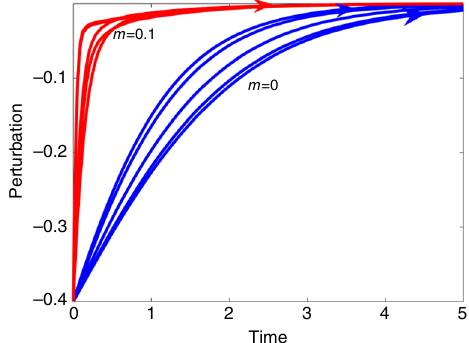
Fig. 1 Resilience of Mutualism. Trajectories of a perturbed n = 10 species Lotka – Volterra model Eq. (1) as it returns to equilibrium. Blue lines are systems with random positive and negative interaction coef fi cients having m ¼ E ð a 0 : 0 and σ ¼ 0 : 05. Red lines are simulations mutualistic ij Þ ¼ systems having random interactions with m ¼ E ð a 0 : 1, σ ¼ 0 : 05 and ij Þ ¼ all interactions positive. For all simulations, the population is depressed by 0.4 units initially, and the perturbation dies in time to zero. It is easy to see that the return time is much faster for the mutualistic systems. Note that fi ve independent simulations are plotted for each value of m with identical initial conditions. Supplementary Fig. 1 in Supplementary Notes 2 similarly explores the effects of perturbing some 20 species when there are n = 100 species in